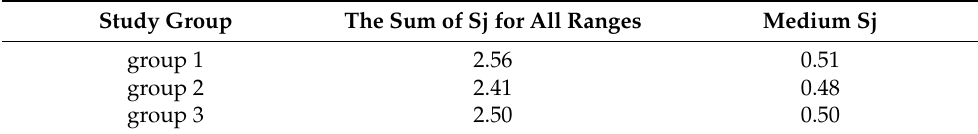
Table 5. Summary of results for individual groups. Source: own research. Study